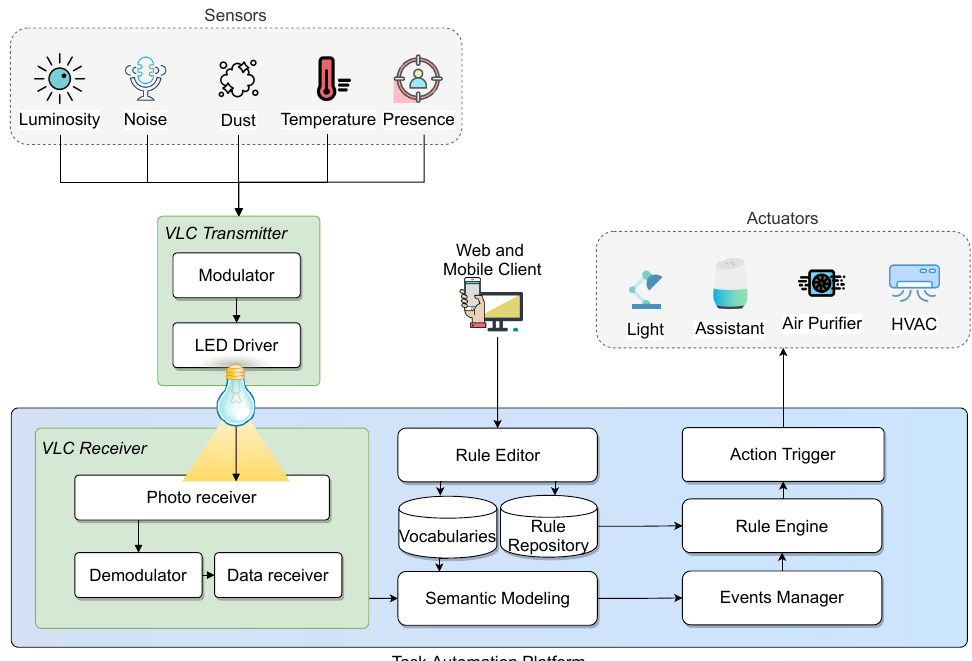
Figure 4. General architecture of the proposed system.